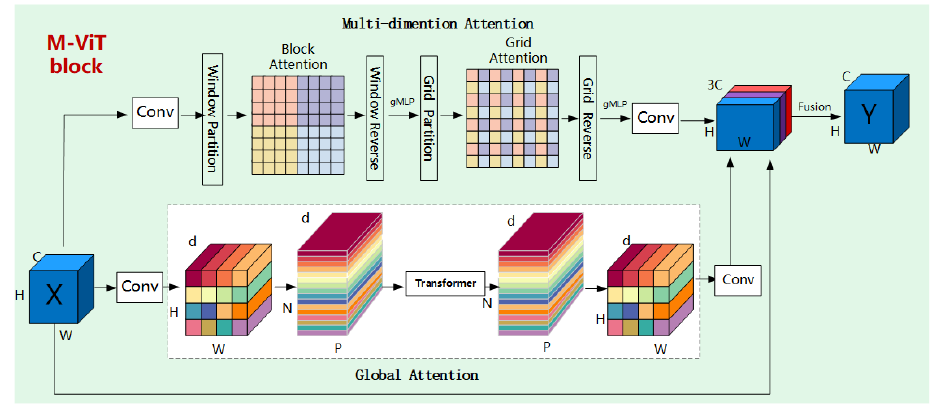
Figure 6. The M-ViT